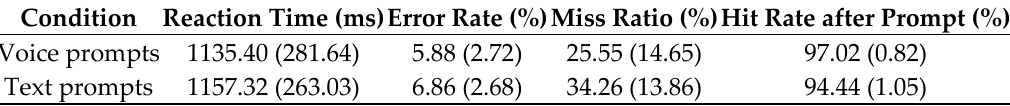
Table 1. Behavioral results and levels of difference.